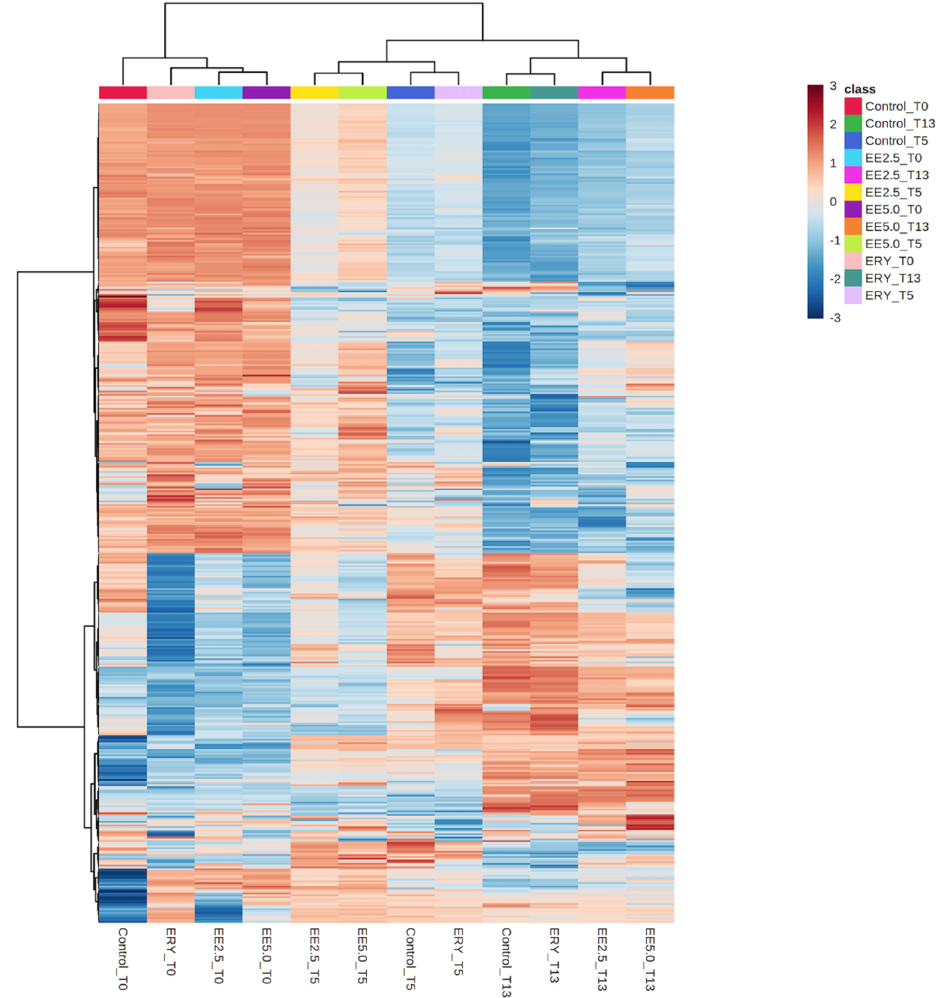
Figure 2. Unsupervised hierarchical cluster analysis (HCA), carried out from the fold-change distribution of each compound detected in CON, EE 2.5, EE 5, and ERY beef burgers during storage (i.e., at 1, 5, and 13 days) by using untargeted metabolomics.